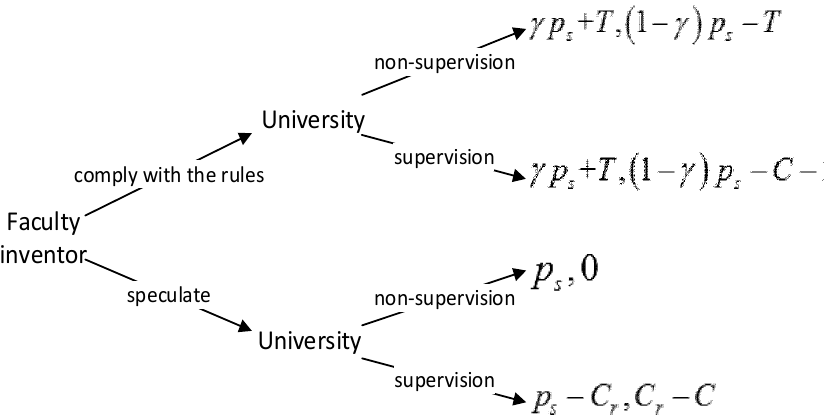
Figure 3. The decision-making tree of the game model between faculty inventors and universities.